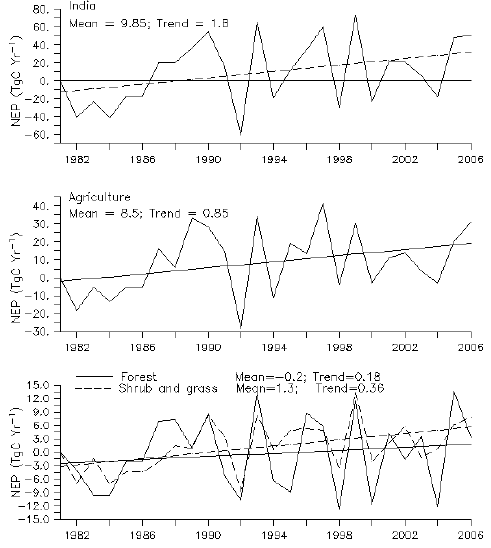
Figure 3. a) Inter-annual variation of total annual NEP (continuous) during the study period and linear trend lines (dash line) fitted using the least square procedure; b) the same as above but for the total agricultural lands of the country; c) the same as above but for the forest (continuous lines), and mixed shrub and grassland (dash lines) of the